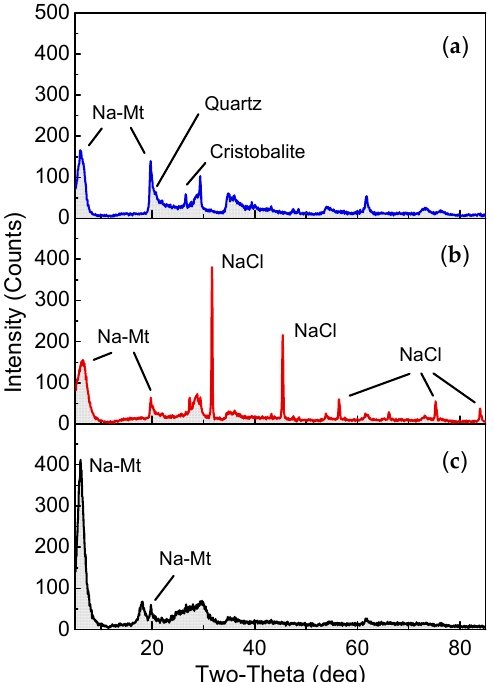
Figure 1. XRD pattern of the purification process of the Na-montmorillonite samples: ( a ) the raw sample; ( b ) the sample after Na + -exchange and centrifugation procedure; ( c ) the purified sample after washing with ultrapure water and centrifugation.